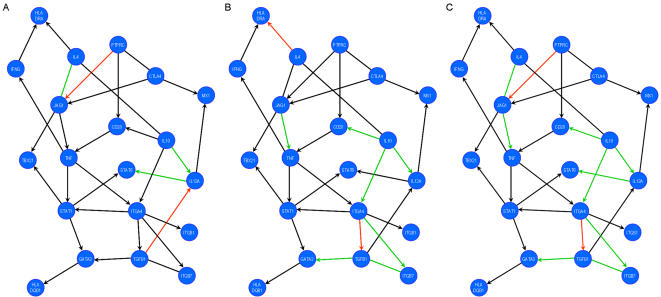
Comparison of the T-cell activation network between patients and controls.A) HC versus untreated MS patients; B) untreated MS patients versus MS patients treated with IFN-ß; C) HC versus patients treated with IFN-ß. Comparisons between gene interaction weights are described using the following colour code: black: no change; green: decreased; red: increased. See Table 4 for statistical analysis.